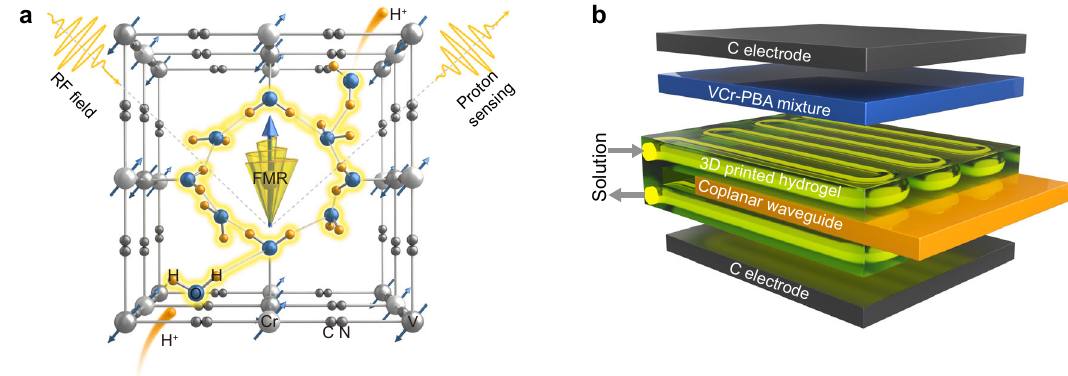
Fig.1|Molecularmagnet-basedionicsforprotonsensing.a Schematic fi gurefor magneto-ionic-based proton sensing. The VCr-PBA has vacancy and hydrogen- bonding networks (highlighted in yellow), allowing for rapid reversible proton transfer through the diffusion-free Grotthuss mechanism. The incident RF fi eld could couple with the molecular magnetization through ferromagnetic resonance (FMR). The RF power is absorbed by the precessing magnetization (Larmor pre- cession) of the molecular based-magnet, resulting in the loss of power of the